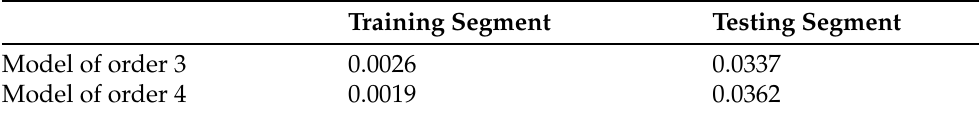
Table 7. NRMSE errors for respective model orders and 10 variables.